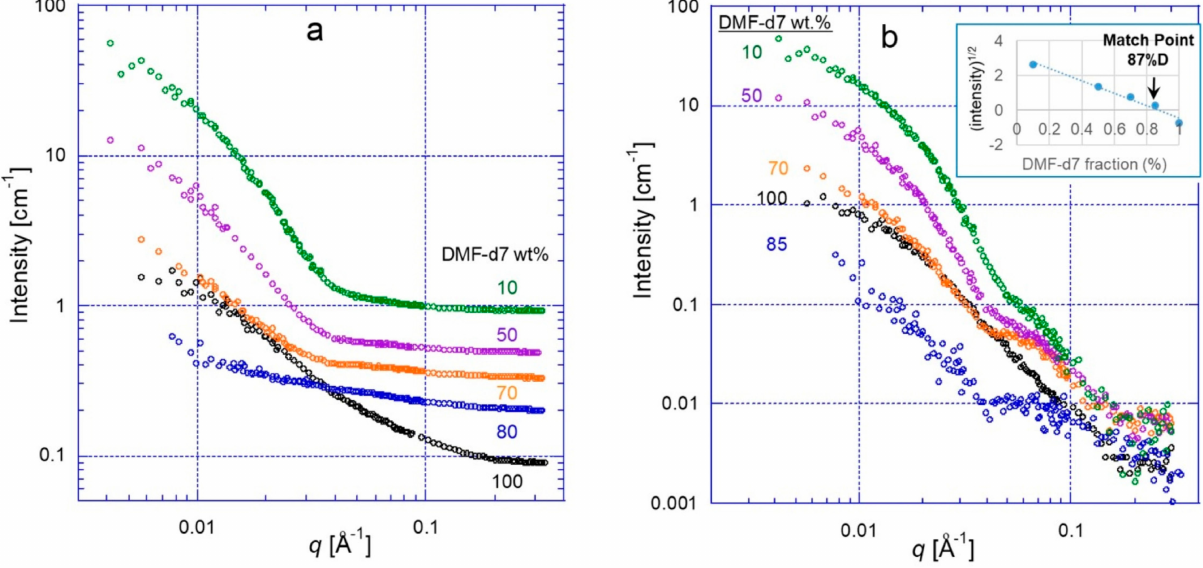
Figure 6. SANS patterns of 0.5 wt.% MWCNT + 1 wt.% dS4VP dispersions, at five different contrasts: 100, 85, 70, 50, and 10% DMF-d7, before ( a ) and after ( b ) background subtraction. Insert in ( b ) shows the matching point plot calculated at q = 0.0084 Å − 1